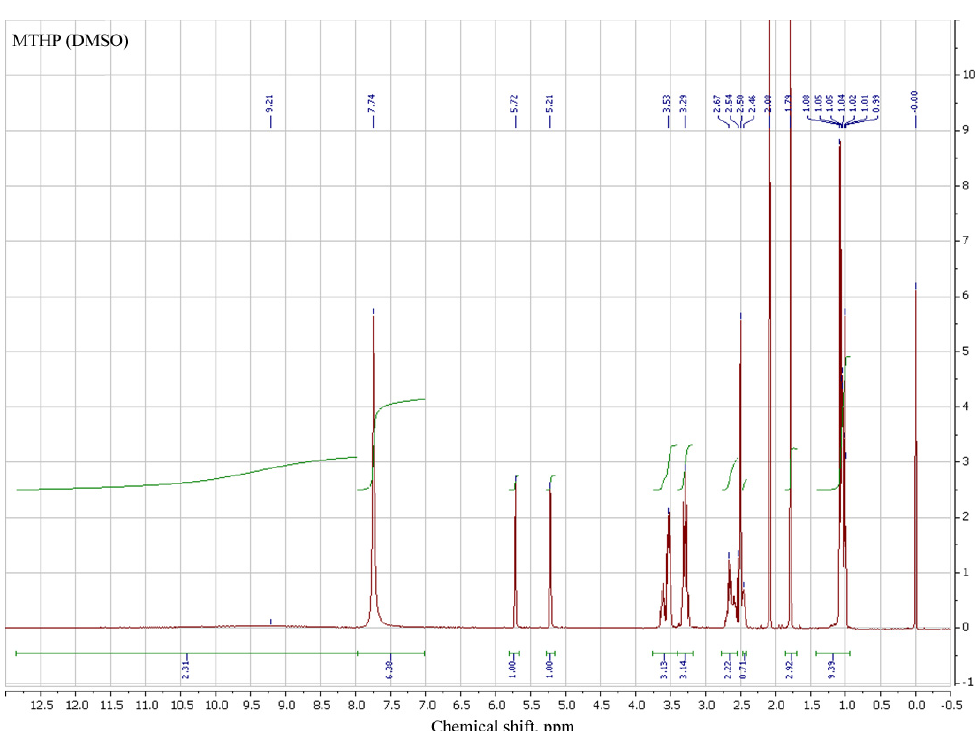
Figure 2. NMR 1 H spectrum of MTHP acetone-insoluble fraction in deuterated DMSO.